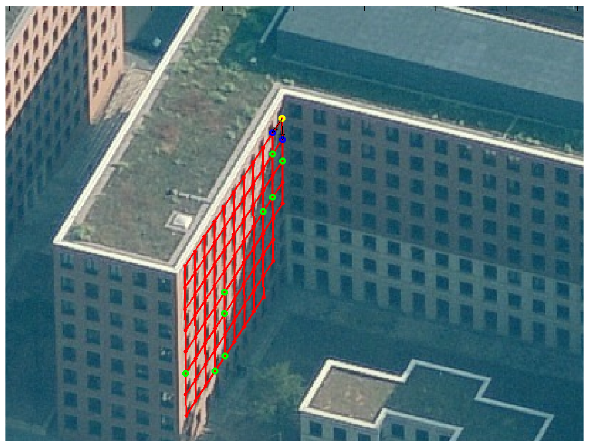
Figure 10: Lattice in oblique aerial image. Red: geocoded lattice; nodes are PS found in SAR geometry. Green: lattice positions without corresponding PS. The line of sight of the SAR sensor is roughly identical with the viewing direction of the airborne camera.